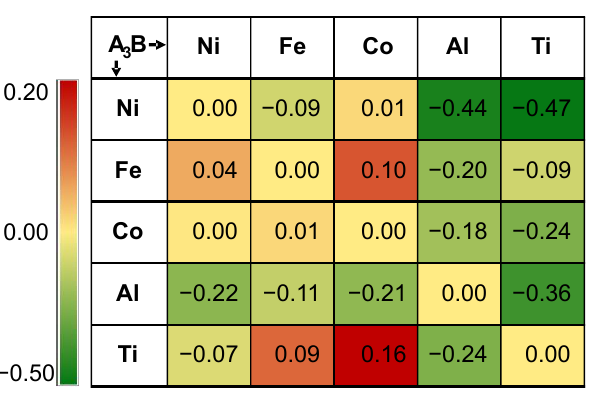
Figure 8. A color map of the formation enthalpies (eV/atom) of L1 2 –A 3 B precipitates in AlCoFeNiTi HEAs. The color scale ranges from green to red, with dark green indicating a formation energy value of − 0.50 eV and dark red a formation energy value of 0.20